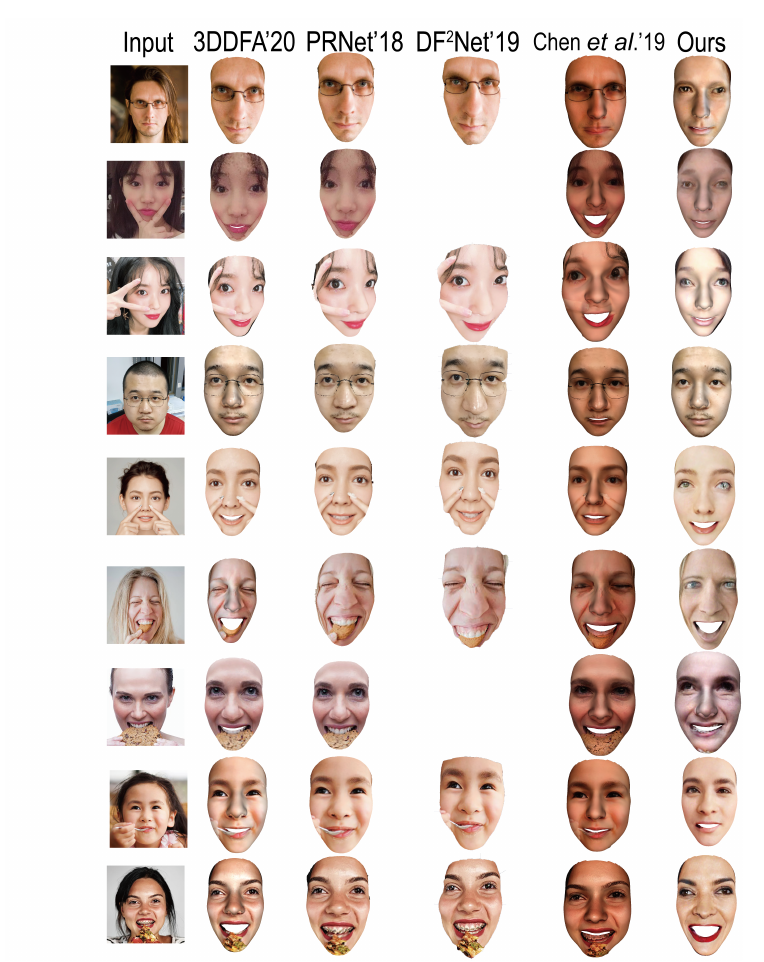
Figure 3. Comparison of qualitative results. Baseline methods from left to right: 3DDFA,PRNet, DF 2 Net, Chen et al. and our method. The blank area means that this method does not